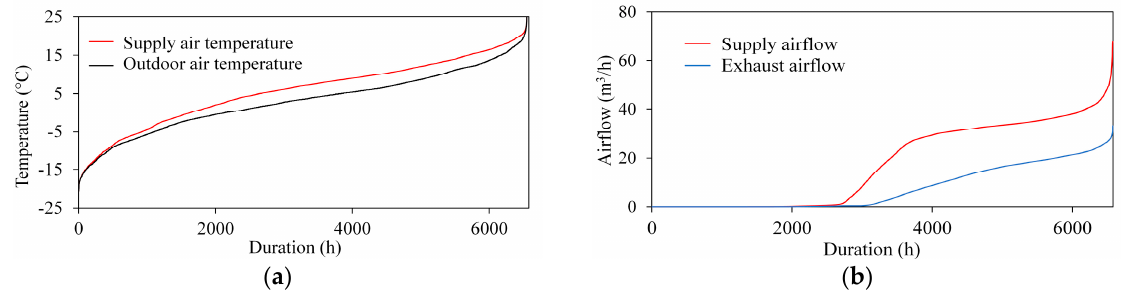
Figure 13. ( a ) Simulated supply air temperature and ( b ) airflow rates duration curves for ventilation unit with regenerative HEX during heating period in 1st floor apartment (September–May).